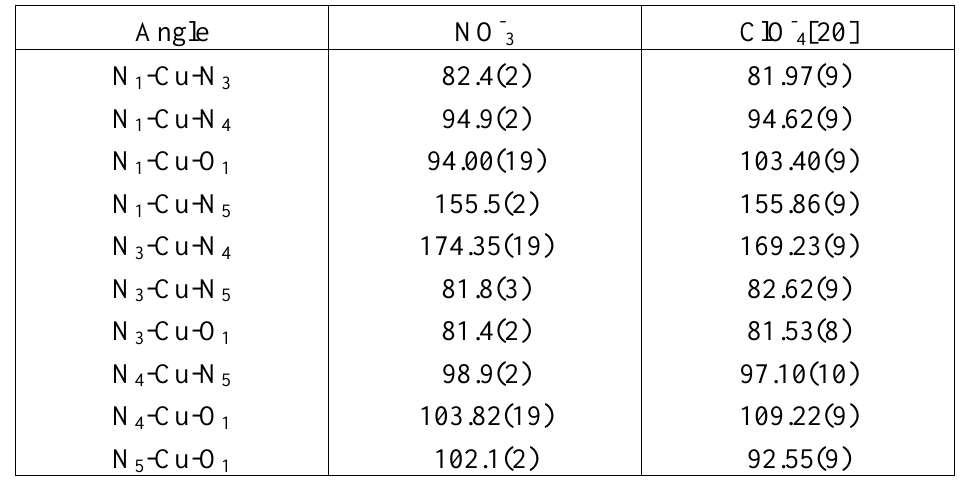
(NO ) and CuLL 0 3 2